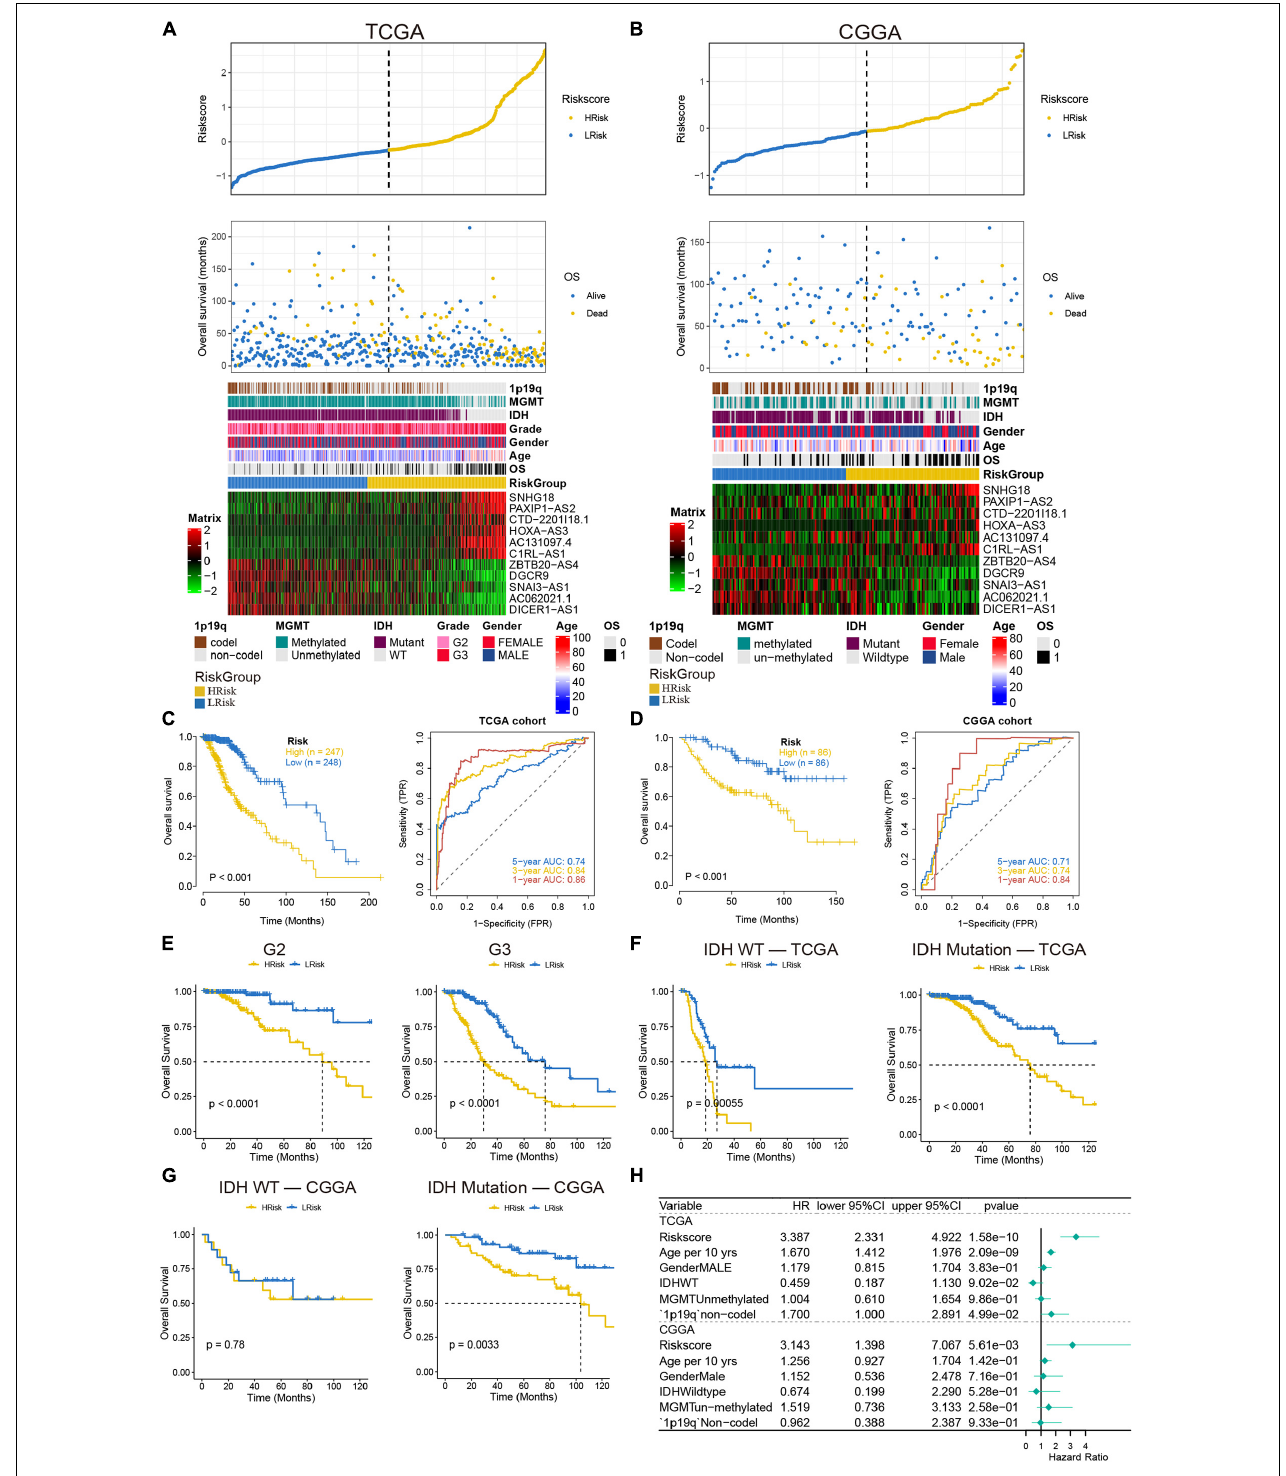
FIGURE 3 | Analysis of prognostic survival of patients with glioma by the risk model. (A,B) The risk score value of each sample, the survival status ranked from low to high-risk scores, and the expression heat map of 11 lncRNAs and clinical features in the TCGA (A) and CGGA (B) cohorts. (C,D) Kaplan-Meier curves and ROC curves were drawn by dividing the high- and low-risk groups based on the risk model in the TCGA (C) and CGGA (D) cohorts. (E) Kaplan-Meier curves based on stages in the TCGA cohort. (F,G) Kaplan-Meier curves based on IDH status in the TCGA (F) and CGGA (G) cohorts. (H) The forest plot of multivariate Cox regression analysis including the risk model and clinical